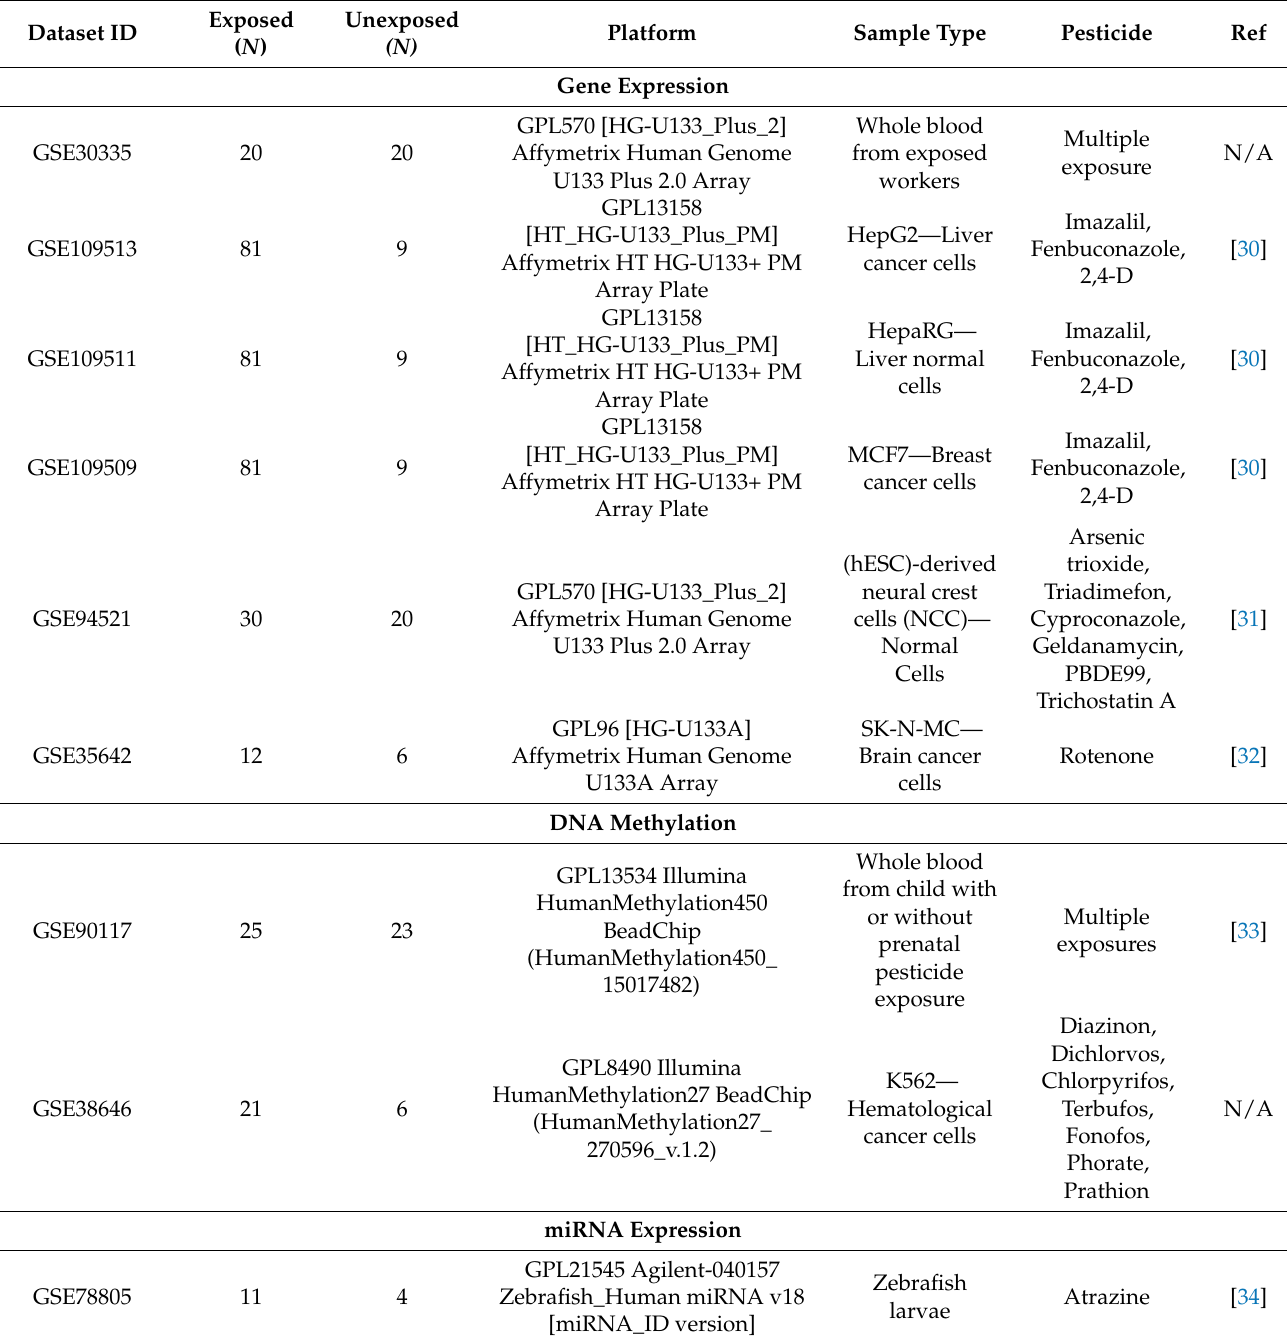
Table 1. Characteristics of the selected